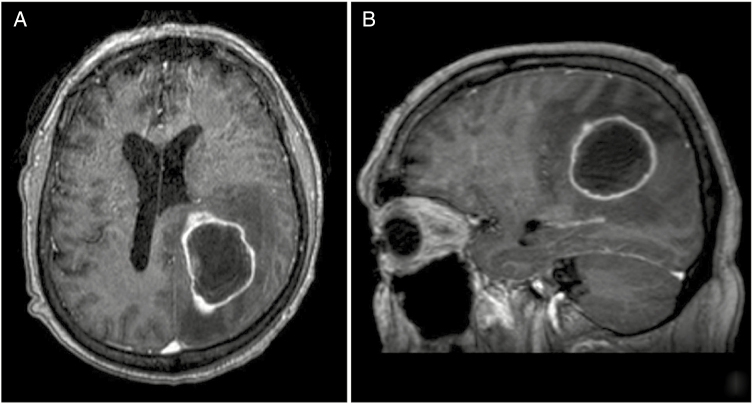
A single, cystic BM in a patient with transitional cell carcinoma of the urinary bladder measuring up to 4.7 cm in the left parietal white matter and involving multiple lobes in the brain, including the left parietal and occipital cortices (A) and (B). The patient presented with right upper extremity weakness, suggesting impairment of the left posterior frontal cortex. How a BM with anatomical involvement of two lobes (parietal and occipital) and functional impairment of a third (frontal) is categorized across studies is variable and may contribute to disagreement in the literature on how BM location affects clinical outcomes. BM, brain metastasis.